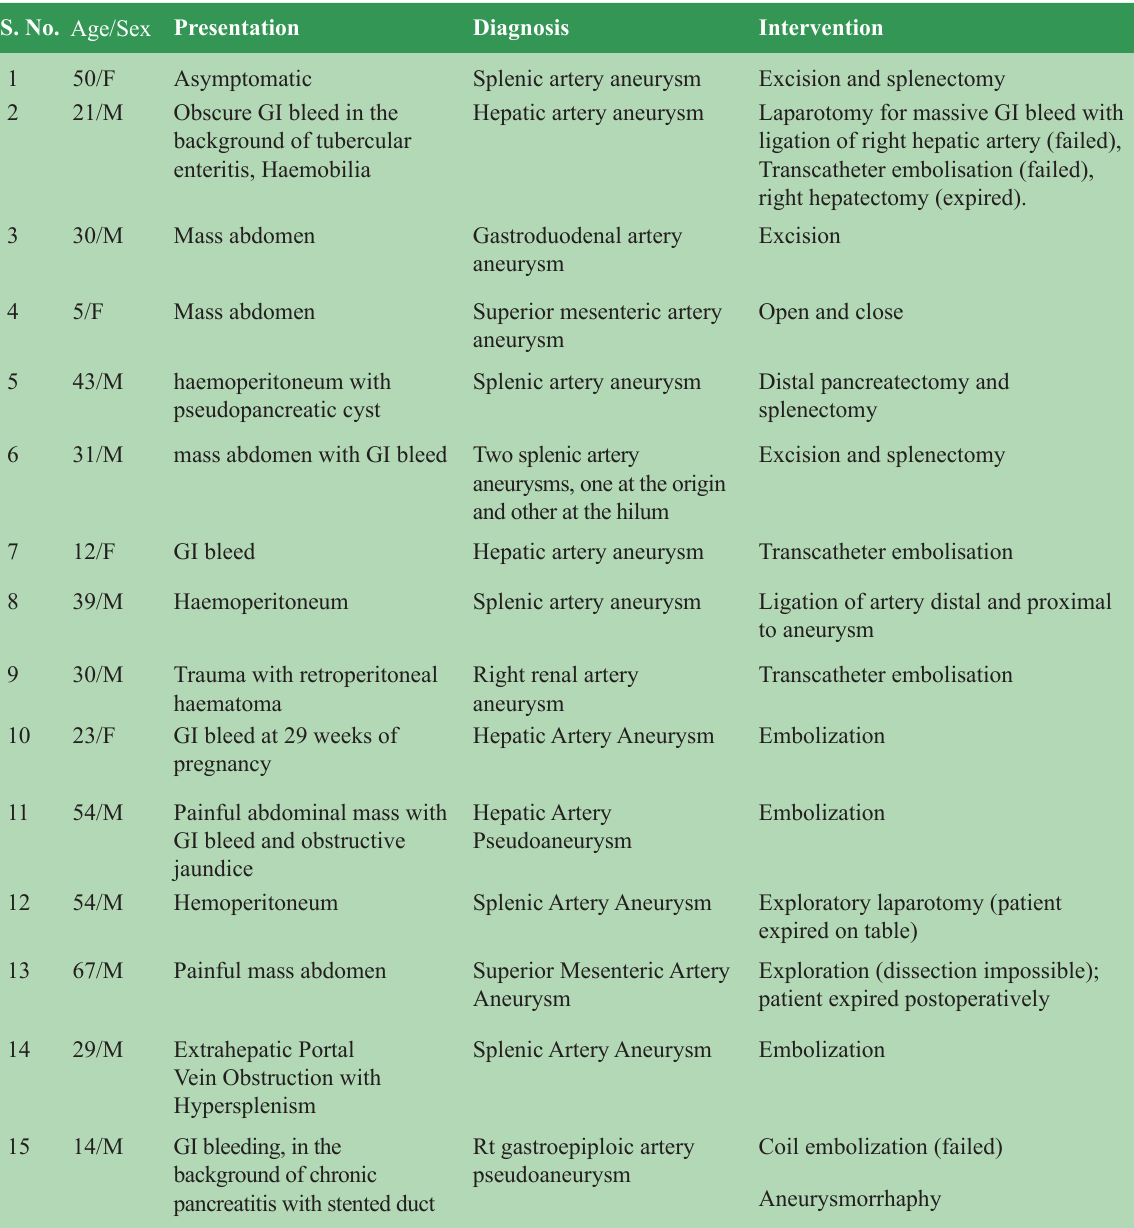
Table 2: Interventions S. No. Age/Sex Presentation Diagnosis Intervention